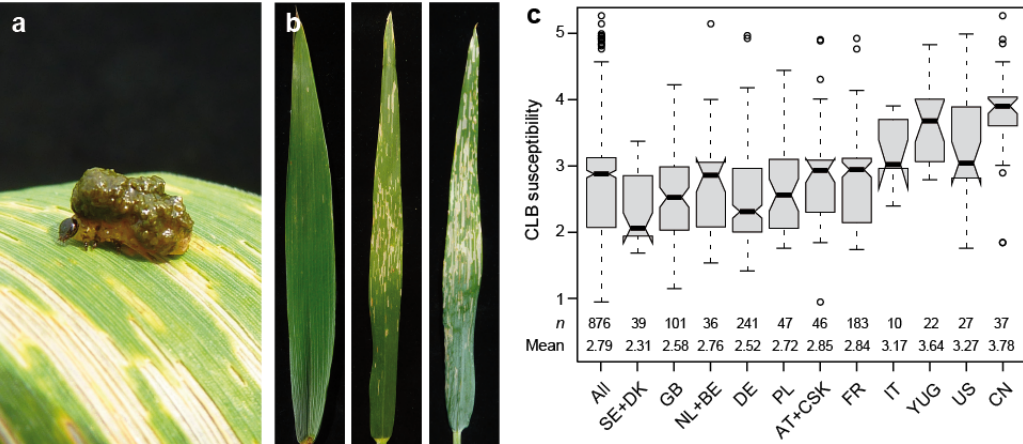
Figure 1. Cereal leaf beetle (CLB) resistance in wheat. ( a ) Cereal leaf beetle larvae on a wheat flag leaf, ( b ) Examples of flag leaves with varying degrees of susceptibility (score of 1, 3 and 4 from left to right), ( c ) Boxplots showing susceptibility dependent on the cultivars’ country of origin. AT, Austria; BE, Belgium; CN, China; CSK, former Czechoslovakia; DE, Germany; DK, Denmark; FR, France; GB, Great Britain; IT, Italy; NL, The Netherlands; PL, Poland; SE, Sweden; US, United States of America; YUG, former Yugoslavia, Serbia, Croatia.